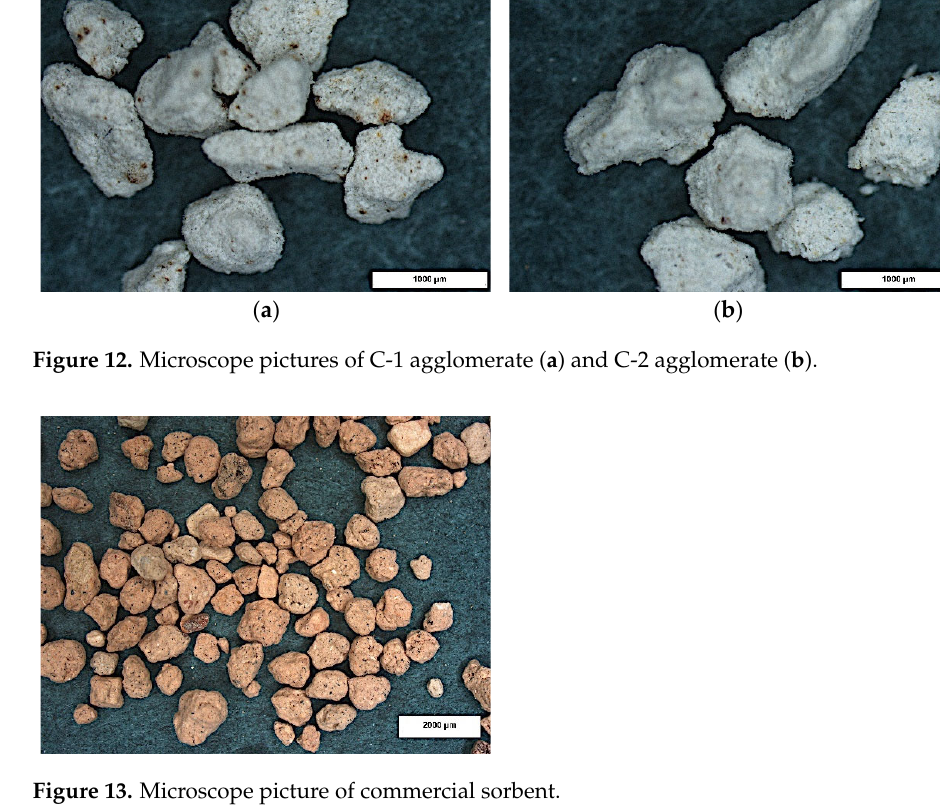
Figure 11. Microscope pictures of B ‐ 1 agglomerate ( a ) and B ‐ 2 agglomerate ( b ).